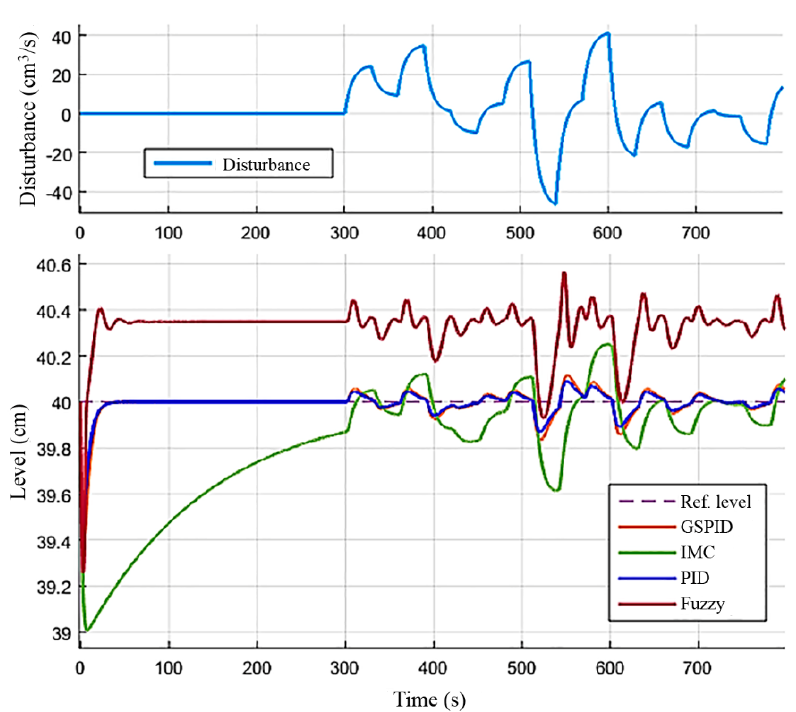
Figure 10. Controller’s response to a 35 to 45 cm reference step.